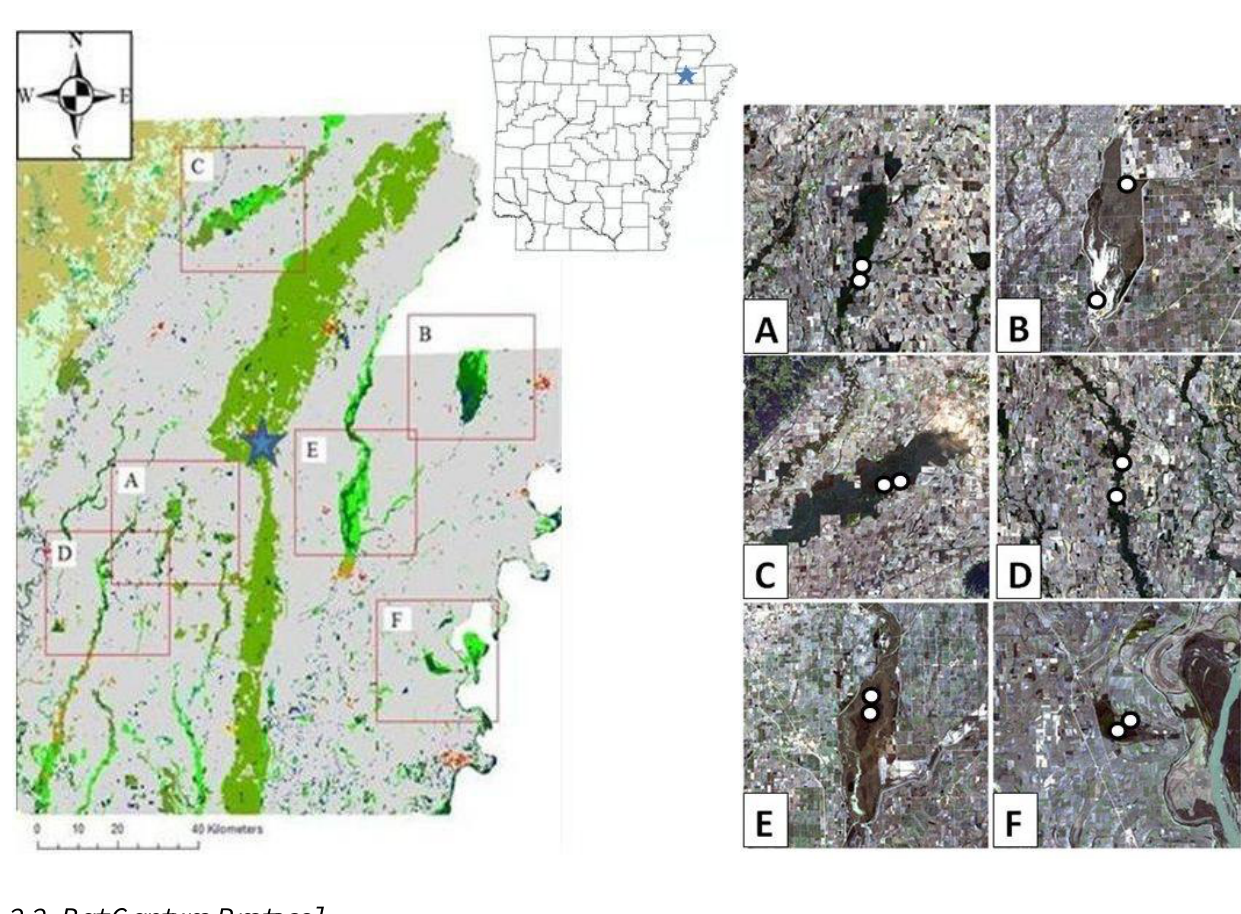
Figure 1. State, regional, and management area maps of the six focal units (A–F) for a 2006 bottomland bat fragmentation analysis. The overall map is an Arkansas county map (www.basecampleasing.com) combined with a 1998 GAP 100 ha Grid landcover map (www.cast.uark.edu), whereas subsets are processed Landsat 7 satellite images (Univ. of AR 2002, Univ. of MA 2006). Map subsets are 30 km × 30 km, with forest indicated by the dark areas and agricultural or urban areas indicated by lighter tones. Mist-netting locations are indicated by white circles. (A) Bayou De View WMA, (B) Big Lake WMA, (C) Black River WMA, (D) Cache River NWR, (E) St. Francis Sunken Lands WMA, (F) Wapanocca